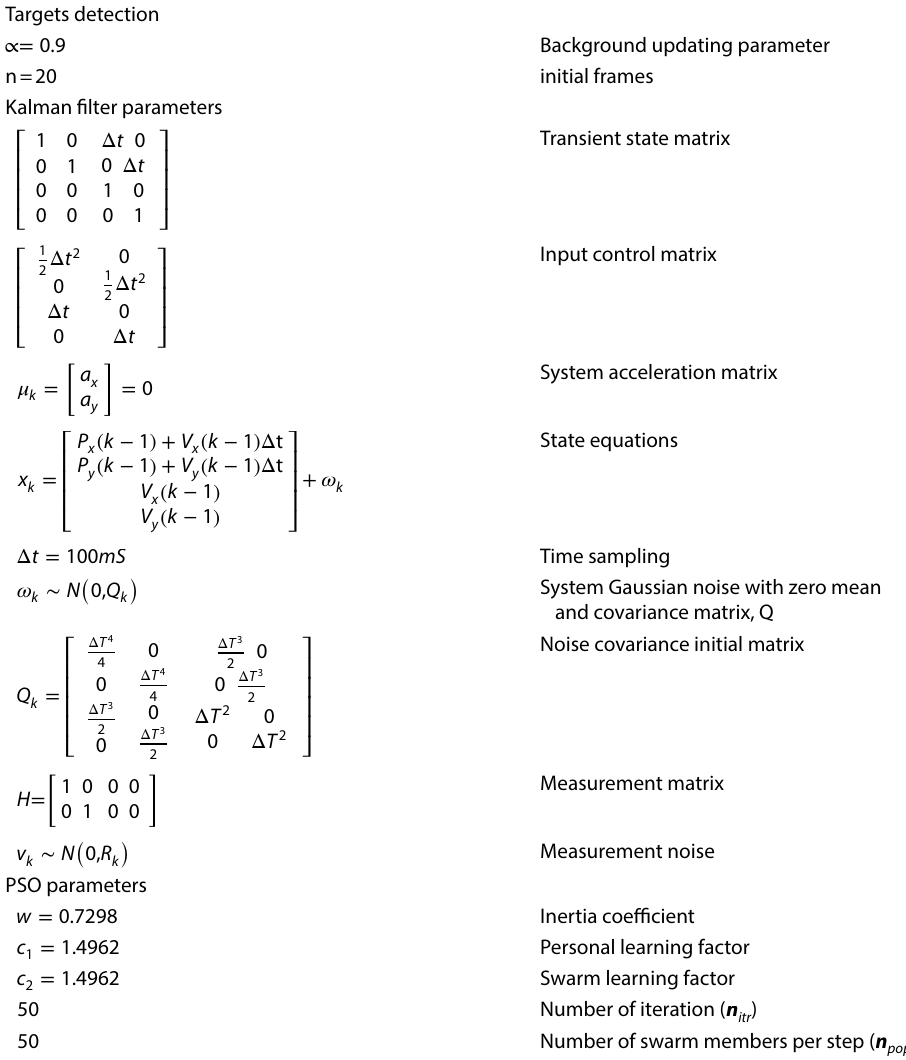
Table 3 Initialization of the intermediate tracker